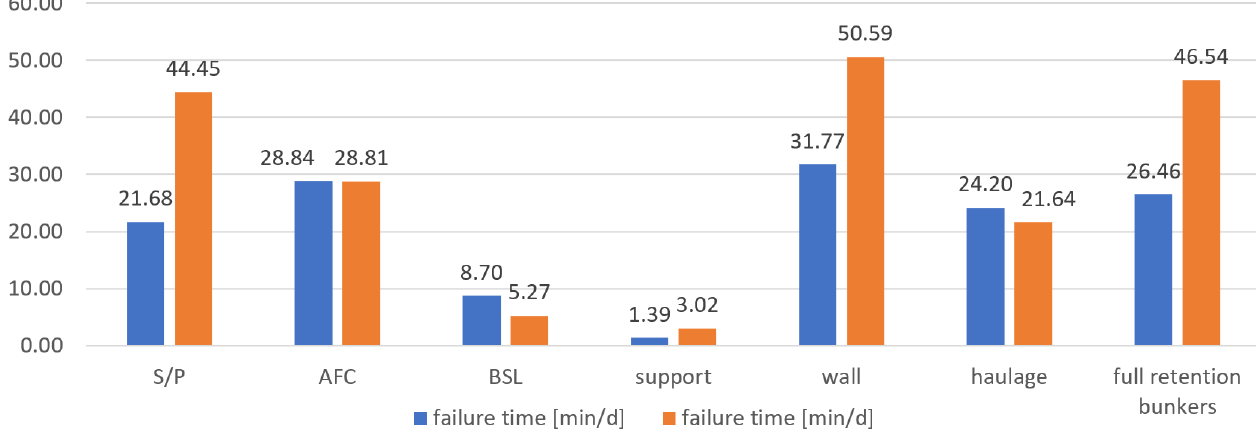
Figure 14. Comparison of the total number of failures per 1000 Mg of excavated material. Figure 15. Comparison of the total failure duration per 1000 Mg of excavated material. 8. Conclusions